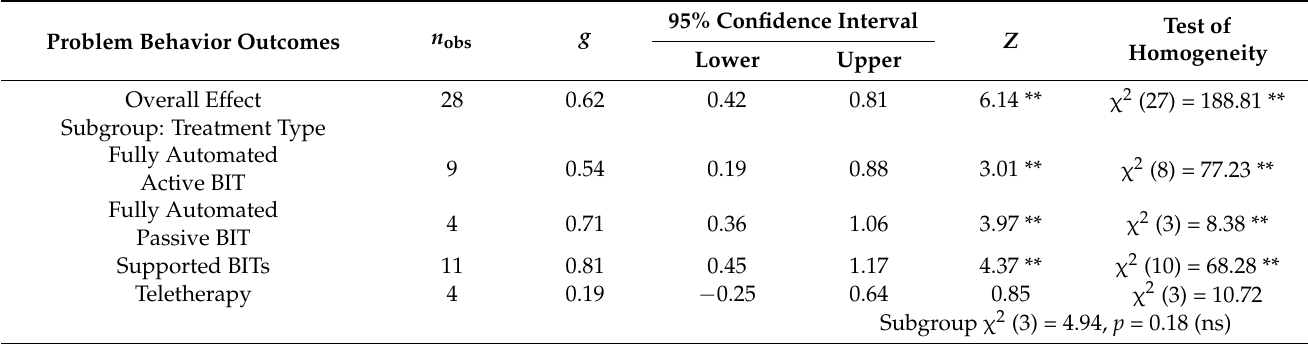
Table 2. Effect size outcomes for BITs subgroups: all